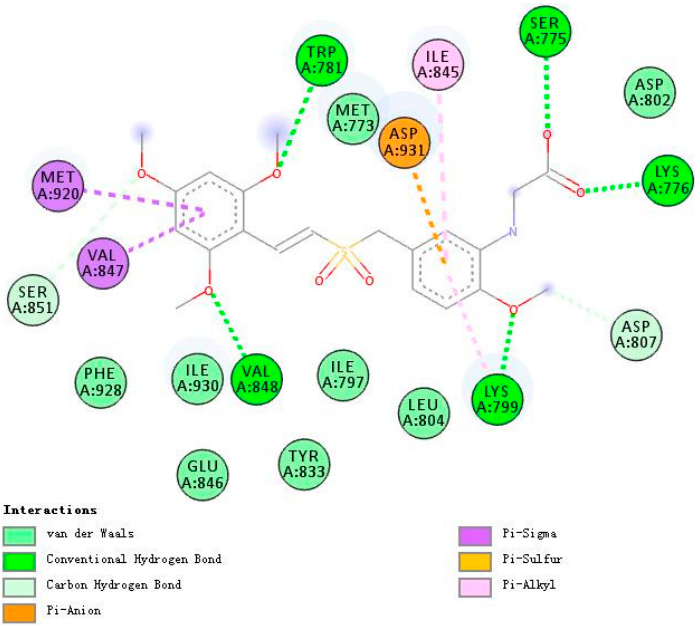
Figure 7. A 2D model of the interaction between rigosertib with the active site of PI3K β .